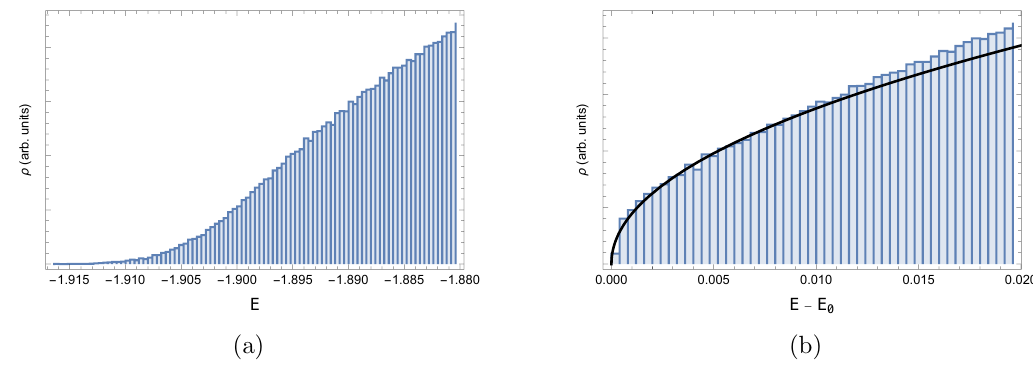
Figure 1. The density of states for SYK near the edge of the spectrum, with N = 42 Majorana fermions and 800 realizations, each with about 1,200 eigenvalues at each edge of the spectrum. (a) The density of states. (b) The density of states, with the energies of each realization shifted by its respective ground state energy. The (cid:12)t is to a power law for the range E (cid:0) E 0 < 0 : 01, and gives (cid:26) (cid:24) ( E (cid:0) E 0 ) 0 : 49 . (The best-(cid:12)t exponent varies between 0 : 4 (cid:0) 0 : 6 depending on the choice of